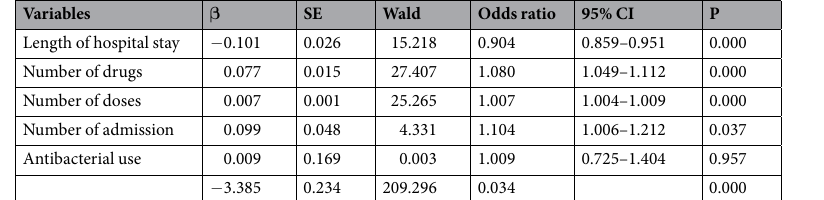
Table 4. Logistic regression results of risk factors for the occurrence of